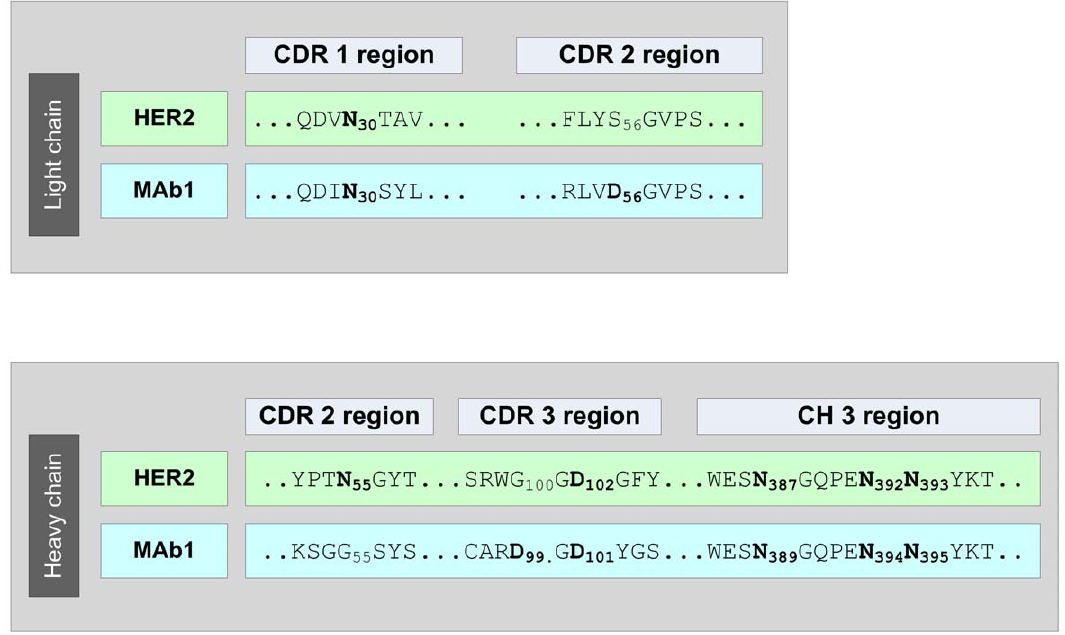
Figure 3. Partial sequences of HER2 and Mab1.